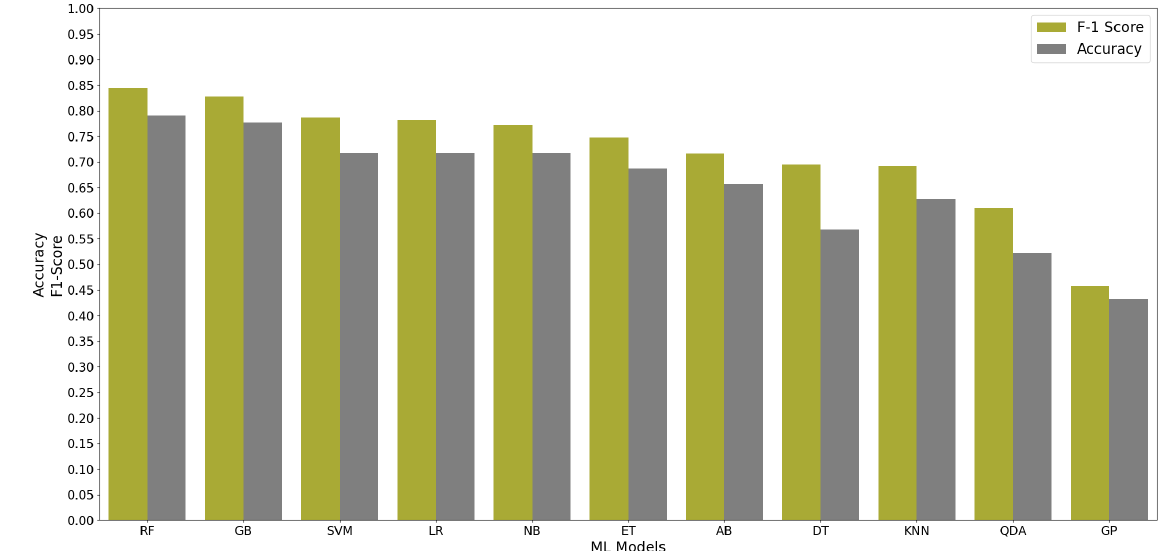
Figure 4. The performance of 11 ML Algorithms when evaluated on Group SN testing dataset using the best 2% of the features determined by the ANOVA test.